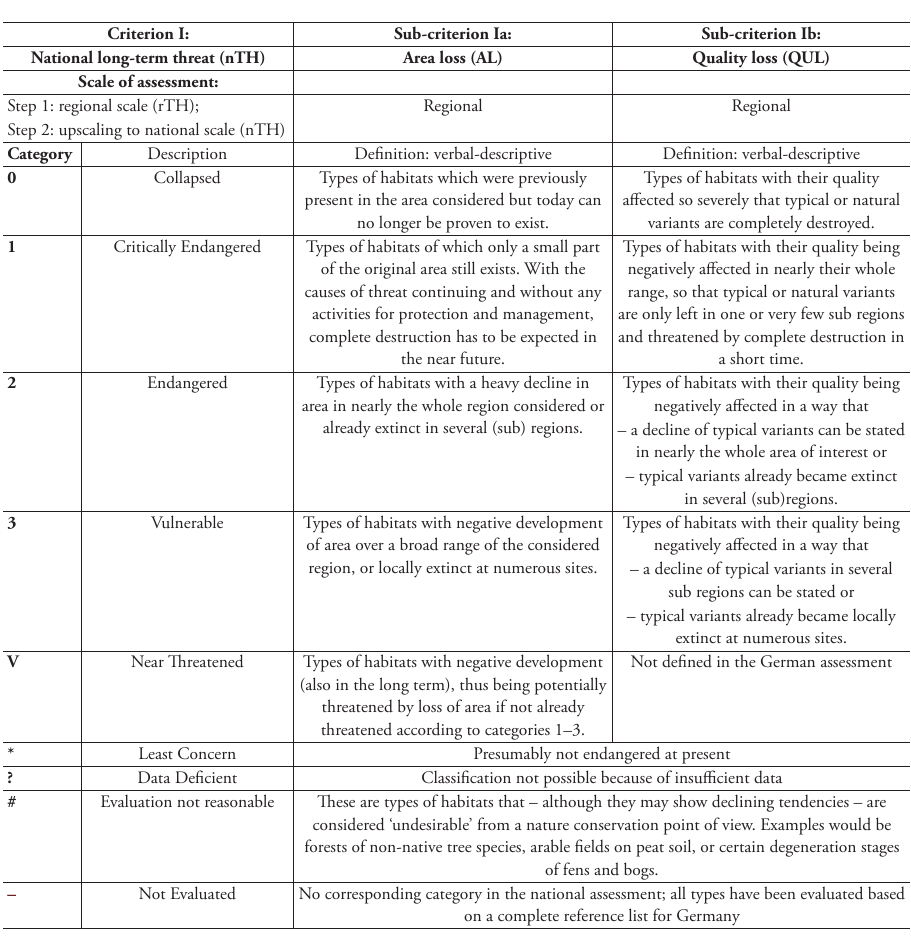
Table 1. Verbal descriptive definition of criterion I ‘National Long-term Threat’ (nTH). Following the ‘precautionary principle’, the highest risk category obtained by any of the two sub-criteria AL and QUL is defined as the overall value of rTH and subsequently